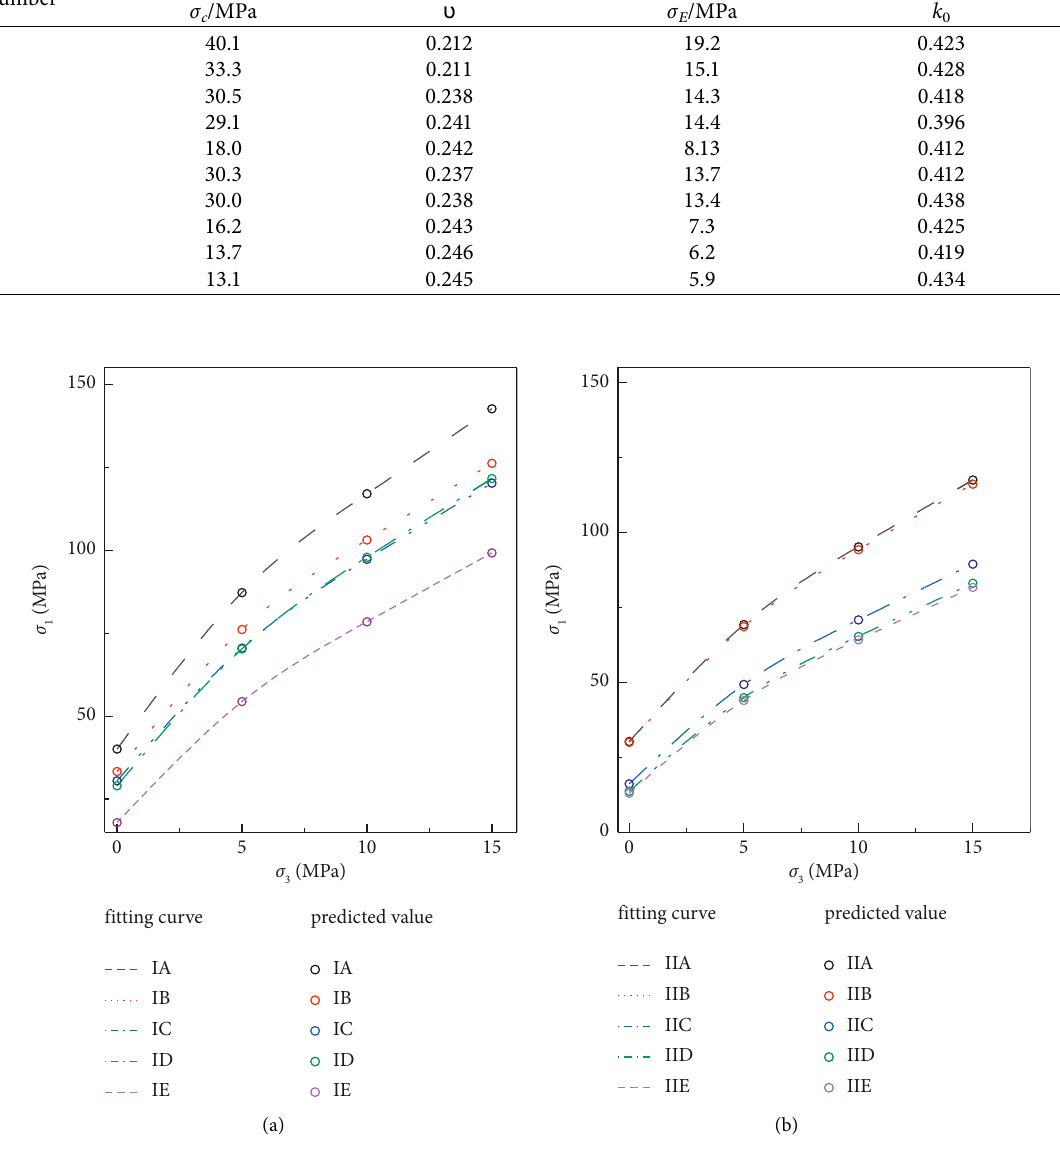
Figure 6: Fitting curve of theoretical strength of F-T sandstone with different moisture